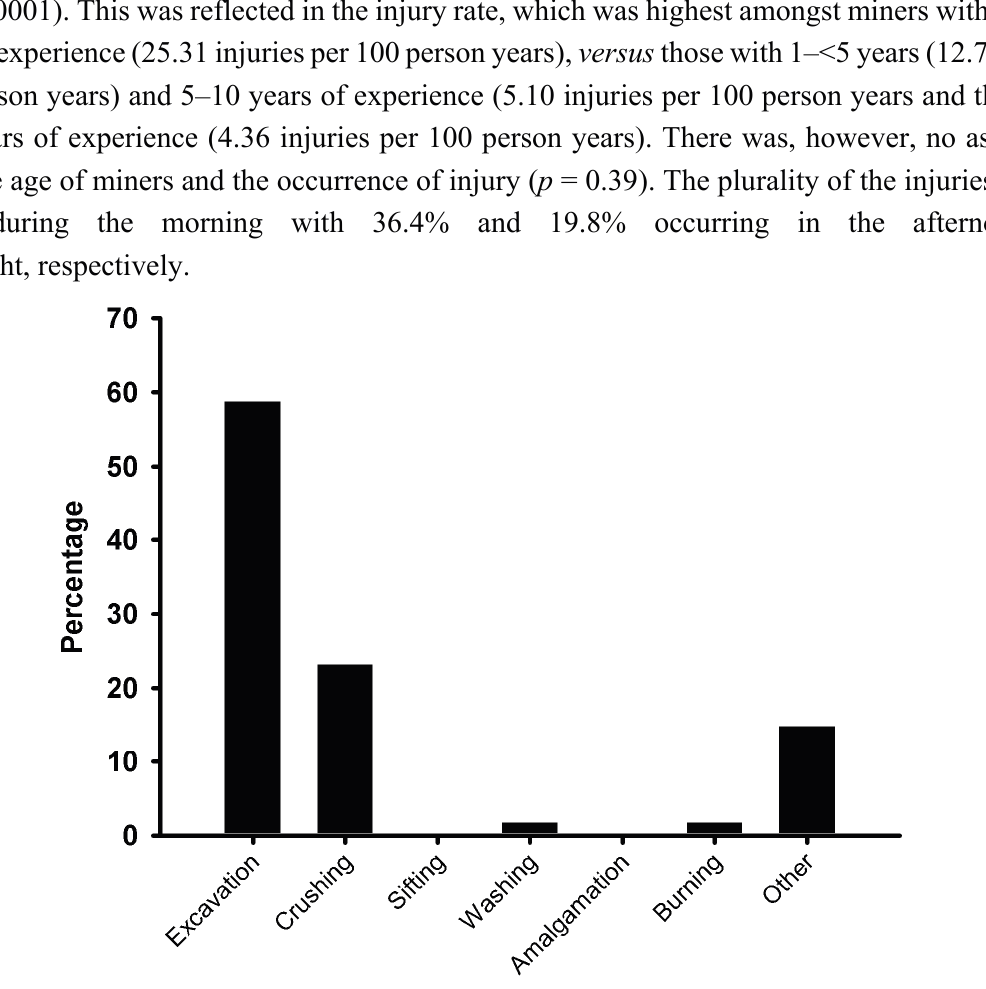
Figure 2. Self-reported activities of artisanal and small-scale gold miners from the Tarkwa (Ghana) study sites at the time of